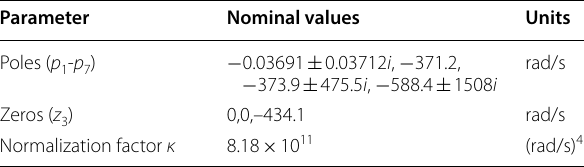
Table 2 Nominal parameters for